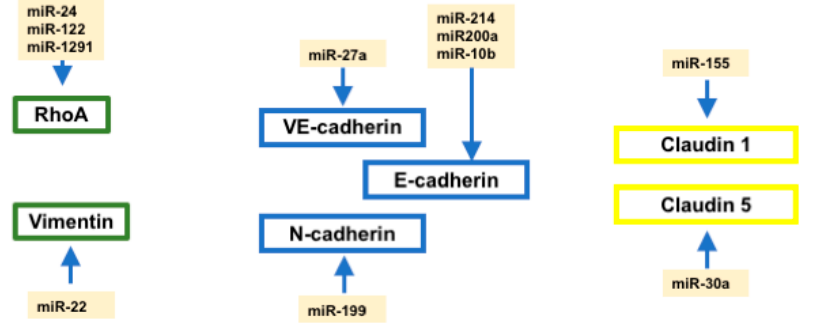
Figure 2. Schematic representation of the microRNAs regulating cytoskeletal and cell–cell contact proteins associated with EMT progression. Abbreviations: VE-cadherin, vascular-endothelial cadherin; E-cadherin, epithelial cadherin; N-cadherin, neural cadherin.